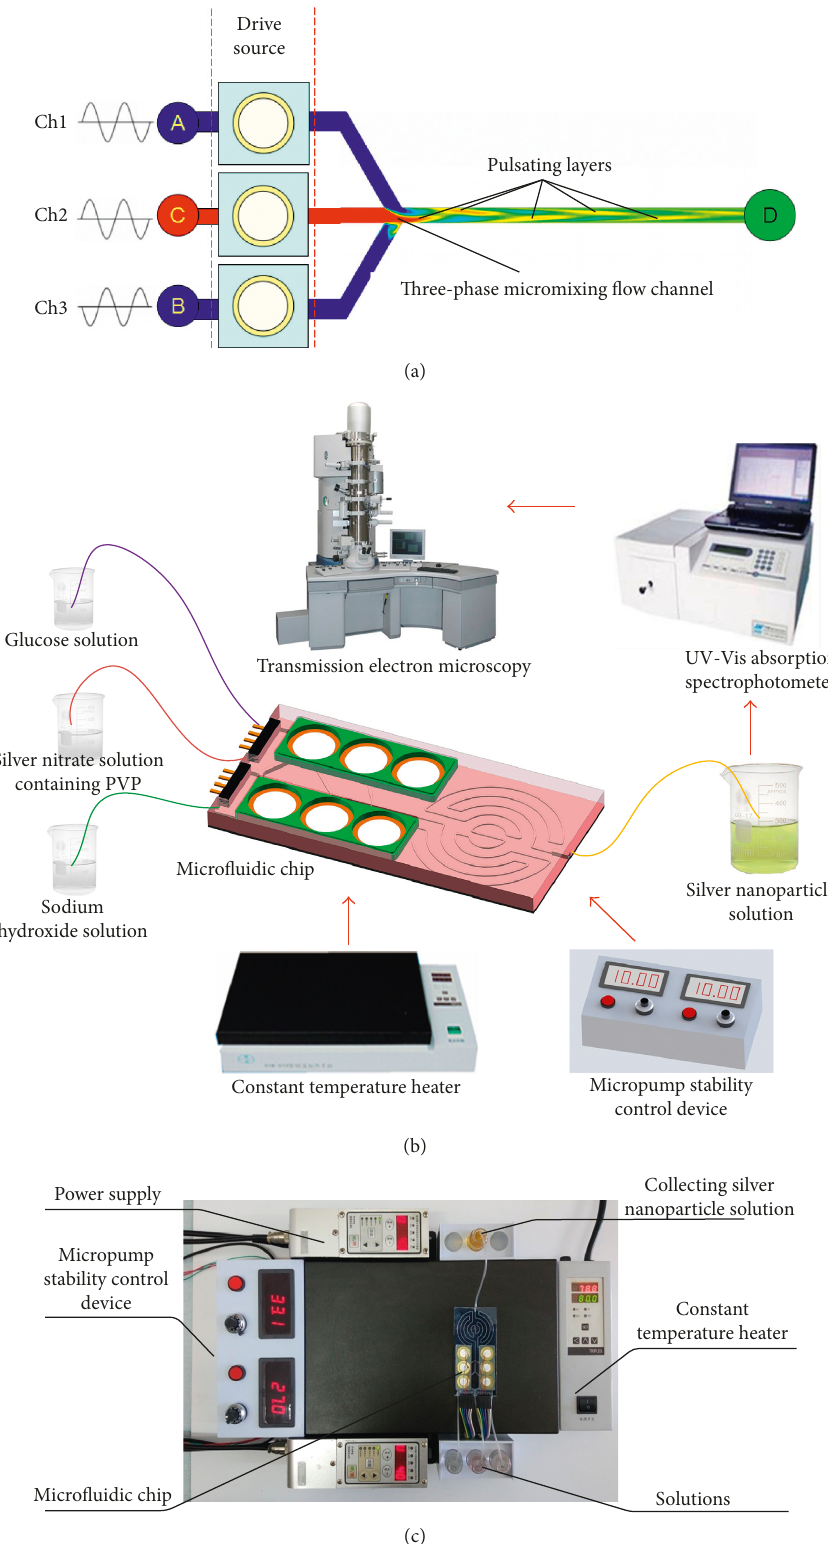
Figure 2: (a) Schematic diagram of the three-phase flow pulsating mixing mechanism. (b) Schematic diagram of experimental scheme. (c) The experimental platform